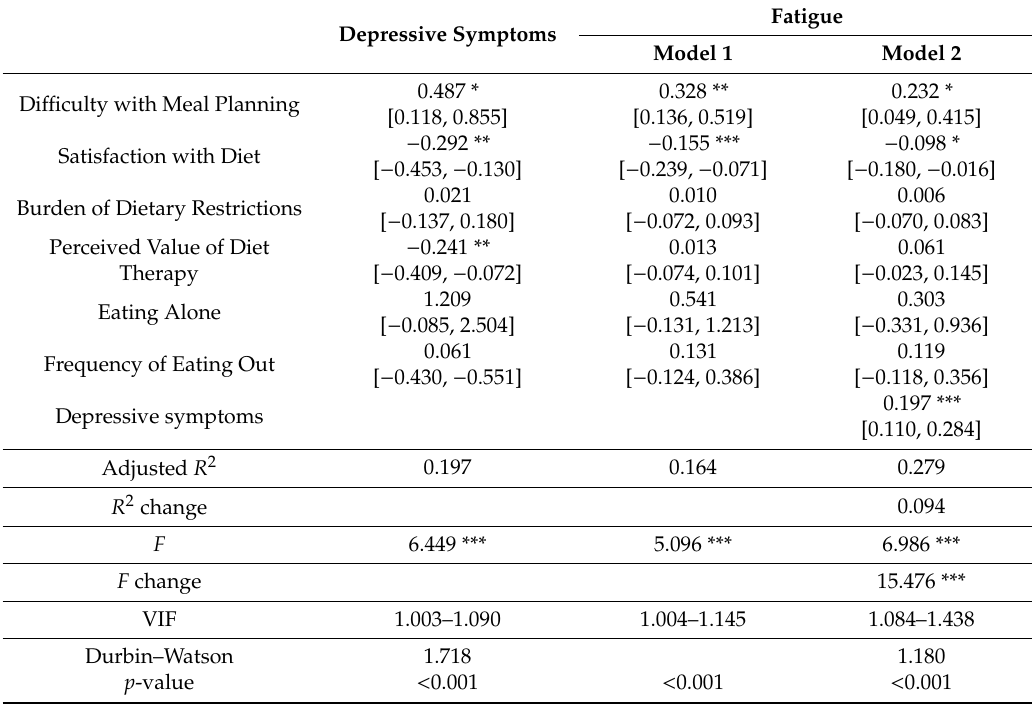
Table 2. Multiple linear regression for predicting mediation e ff ect of depressive symptoms on fatigue. Fatigue Depressive Symptoms Model 1 Model